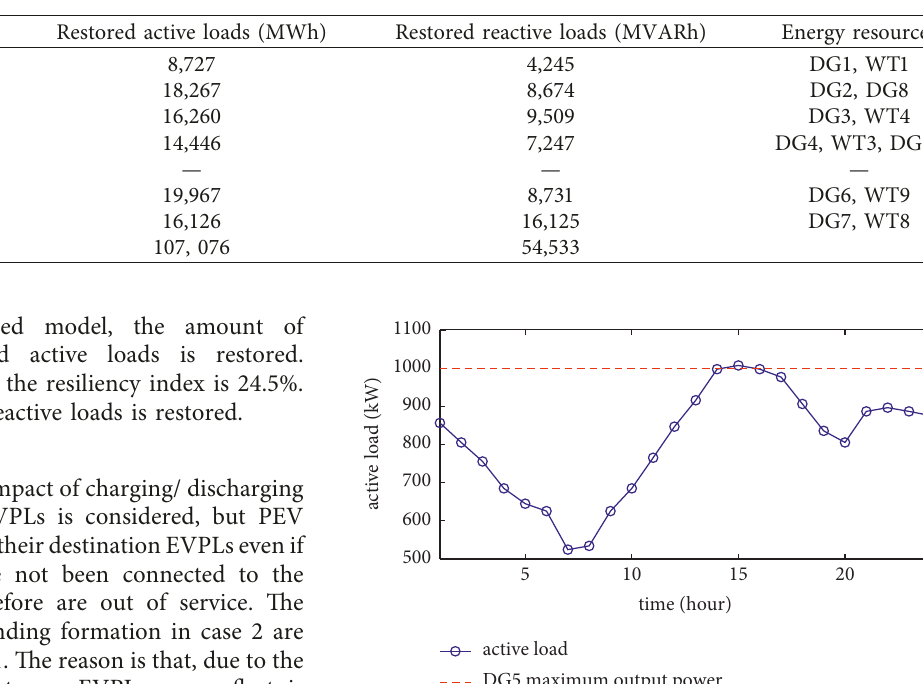
Table 5: The features of six formed islands in case 1.